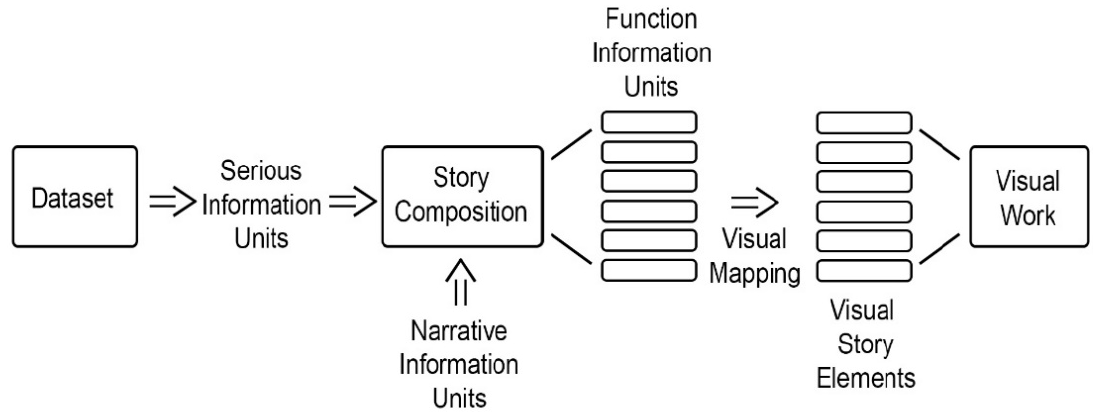
Figure 7. The basic procedure of processing information units.